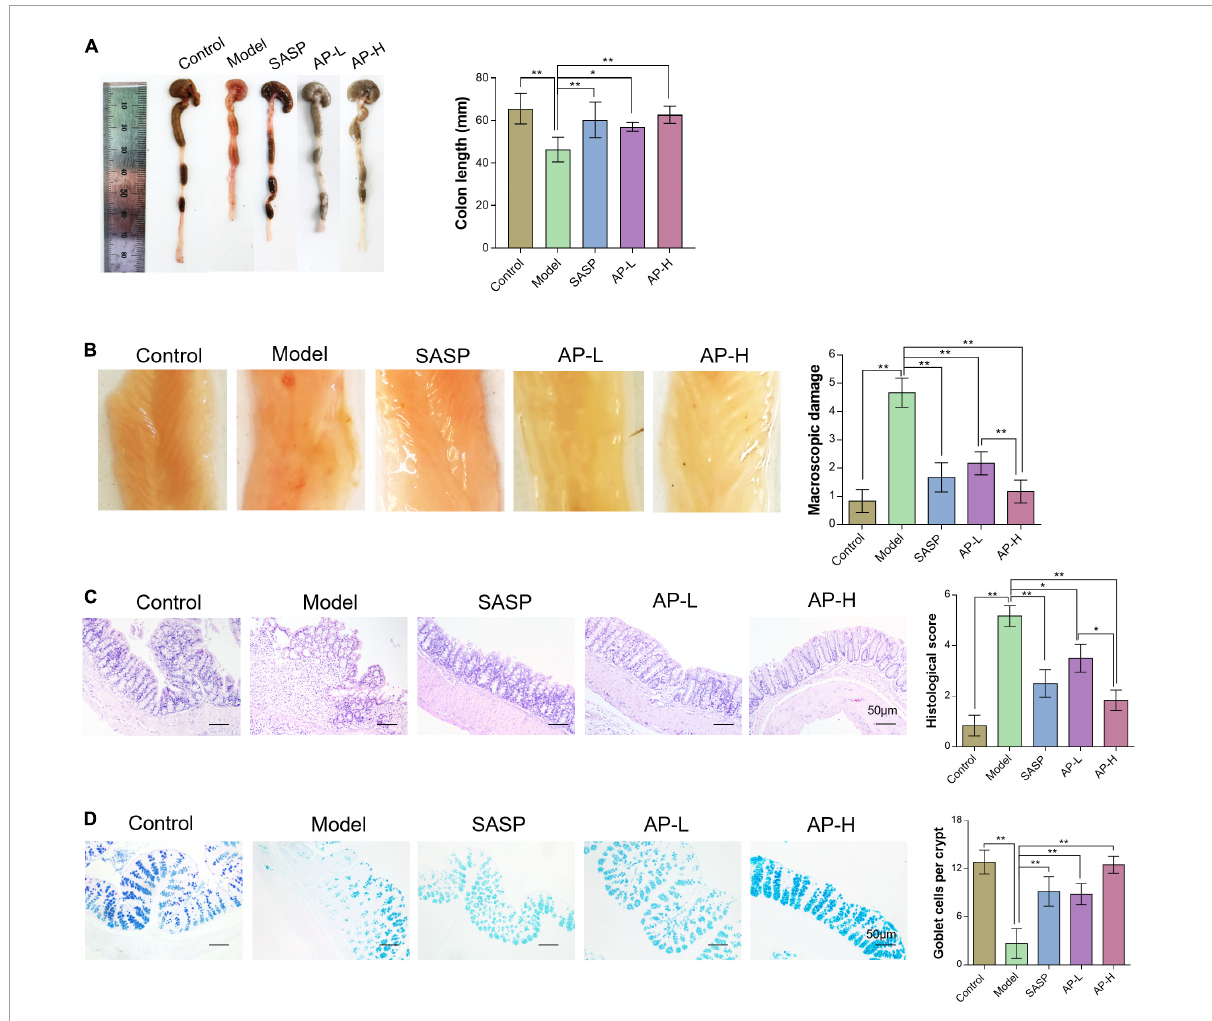
FIGURE2 Apigenin attenuated DSS-induced colon injury. (A) Representative pictures of colon gross appearance and colon length. (B) Colonic morphology and associated macroscopic damage scores in mice. (C) H&E staining of the colon in mice and related microscopic lesion scores. (D) AB-PAS staining of colon tissues in mice among different groups. * P < 0.05, ** P < 0.01.